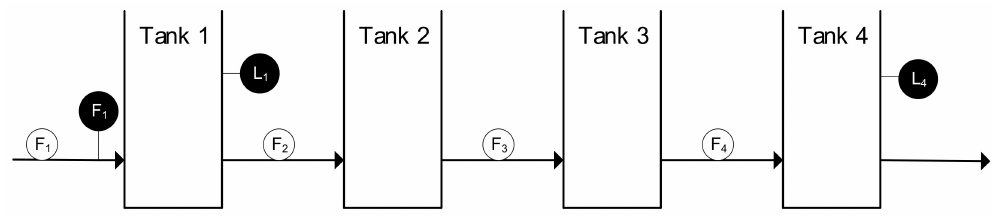
Figure 2. Diagnosed process—set of serially connected pressure liquid storage